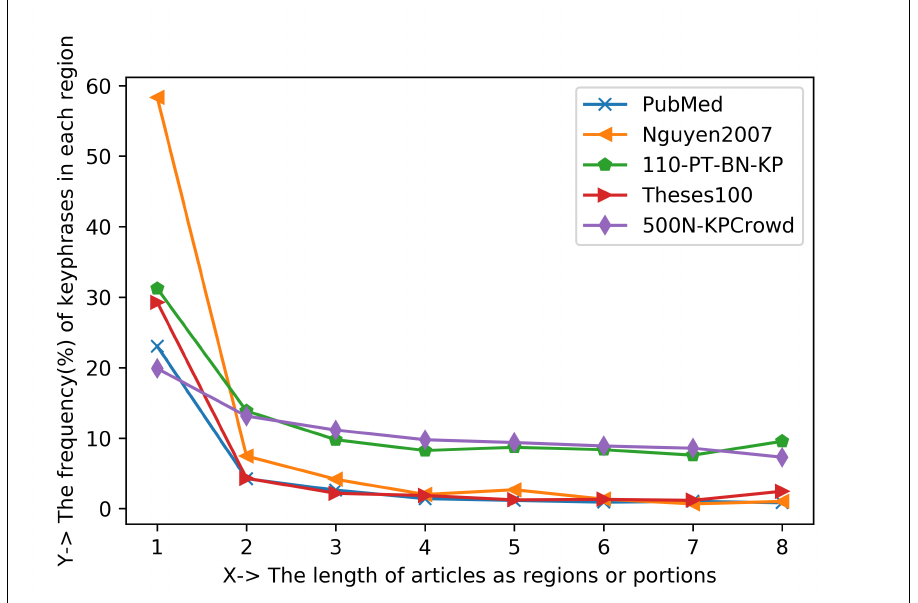
Figure 8. The analysis of keyphrase frequency in percent (%) using first occurrence keyphrase based on eight regions for 2nd five